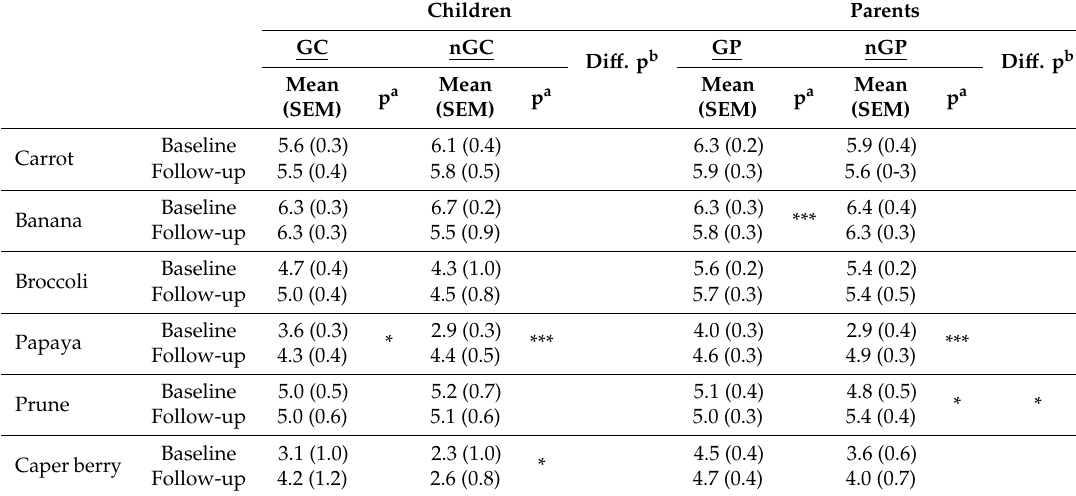
Table 3. Mean (SEM) of liking of the six fruit and vegetables (F&V) at baseline and follow-up (1 =